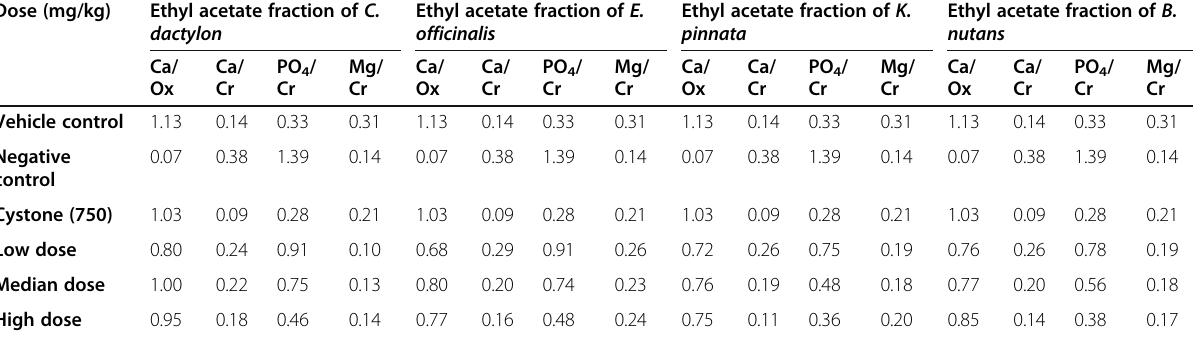
Ethyl acetate fraction of B. nutans